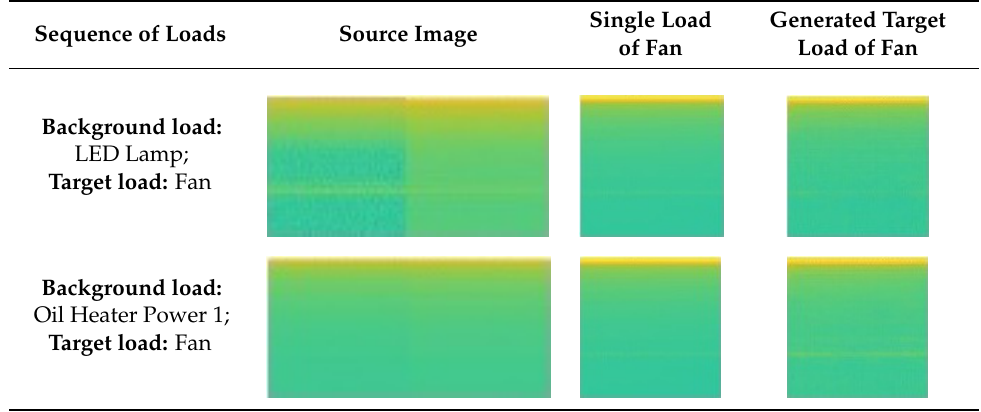
Table 7. Several results of GAN inference with Fan as target load.